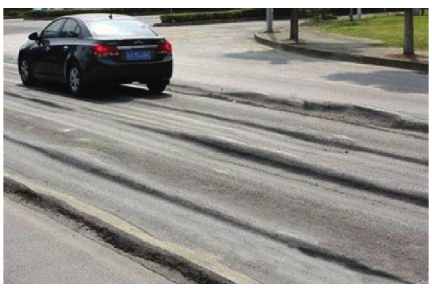
Figure 1: Rutting damage of